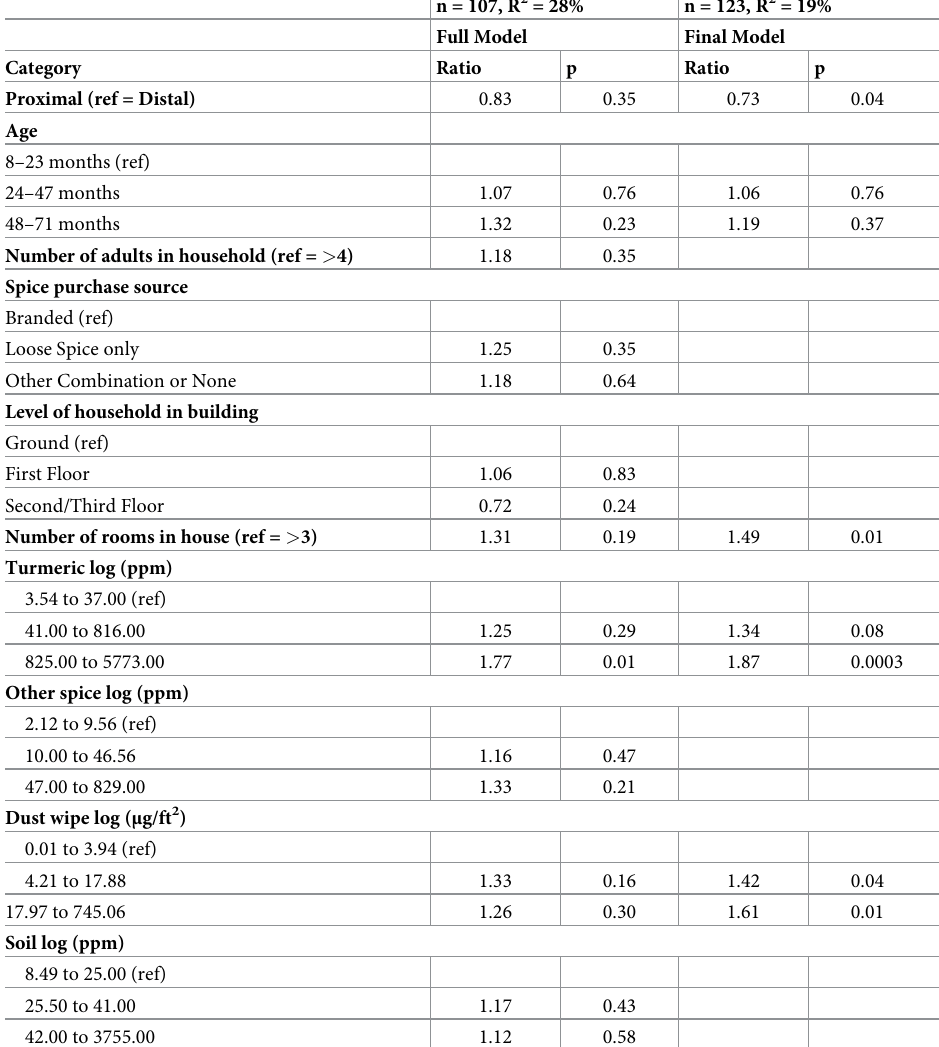
Table 11. Backward models of BLLs and variables significant at p < 0.10, categorical age forced into the model and with R-Squared all children Patna Bihar, 2020. n = 107, R 2 = 28% n = 123, R 2 = 19% Full